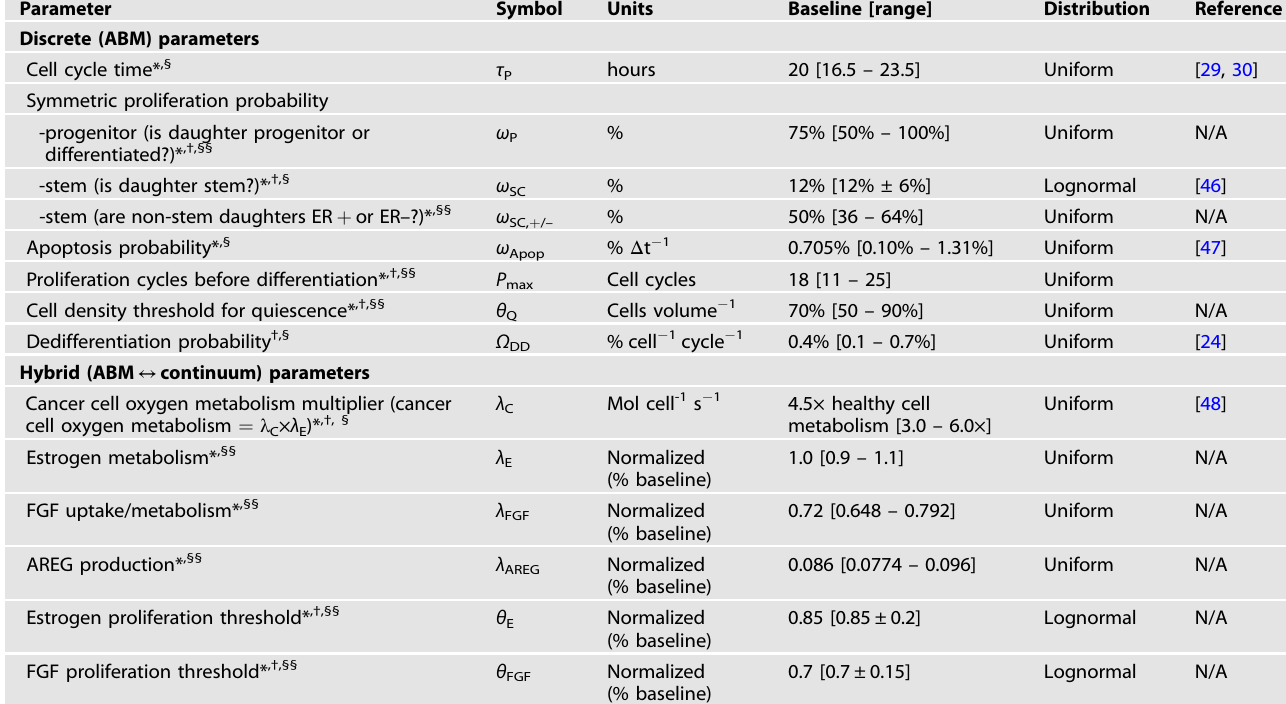
Table 1. Model parameters perturbed in the global sensitivity